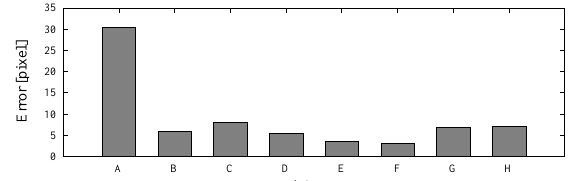
Object ID Figure 15 . Average correspondence errors between the registered templates and the unwarped corneal surface images. Figure 16 . The left image is a snapshot from the evaluation ex- periment. The trial subjects were seated 700 mm from the front of a 24-inch display, which showed nine markers. The right image is the marker used in the evaluation. The trial subjects looked at these markers in